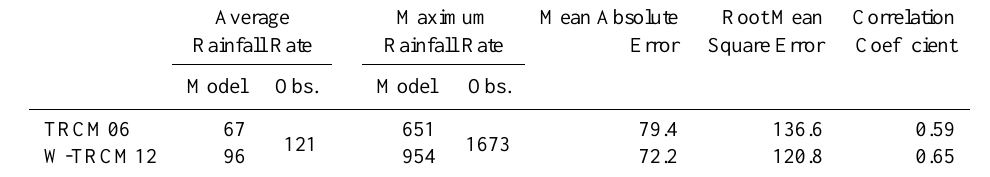
Table 3. Validation results for the statistical parameters of independent westward-moving typhoons that hit Taiwan in 2007–2011. Average Maximum Mean Absolute Root Mean Correlation Rainfall Rate Rainfall Rate Error Square Error Coefficient Model Obs. Model Obs. TRCM06